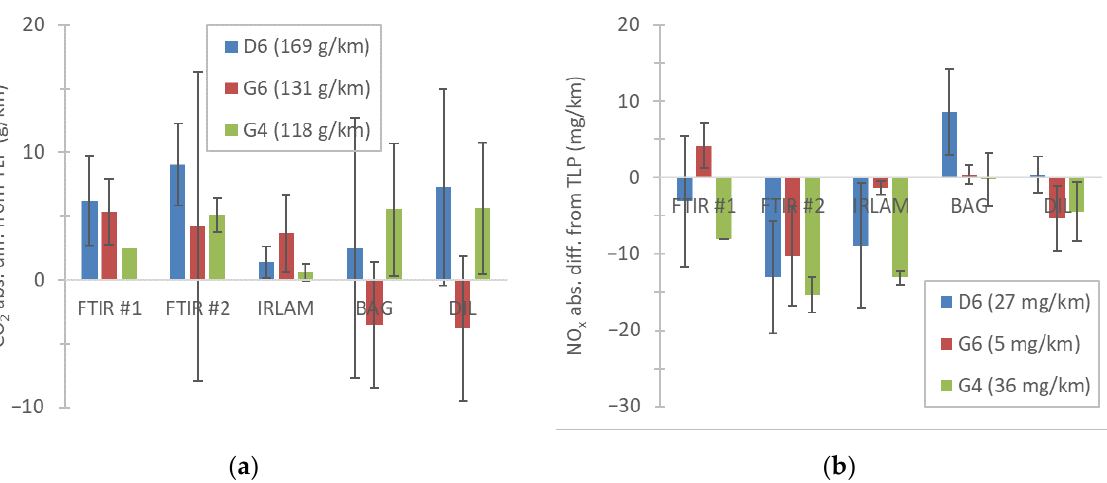
Figure 9. Absolute differences of the instruments from tailpipe analyzers (TLP): ( a ) CO 2 ; ( b ) NO x . Each colored bar is a vehicle: Diesel Euro 6 (D6), gasoline Euro 6 (G6); gasoline Euro 4 (G4). Numbers in brackets are the average absolute emission levels over the driven cycles for each vehicle. Error bars give one standard deviation or max-min the G4.